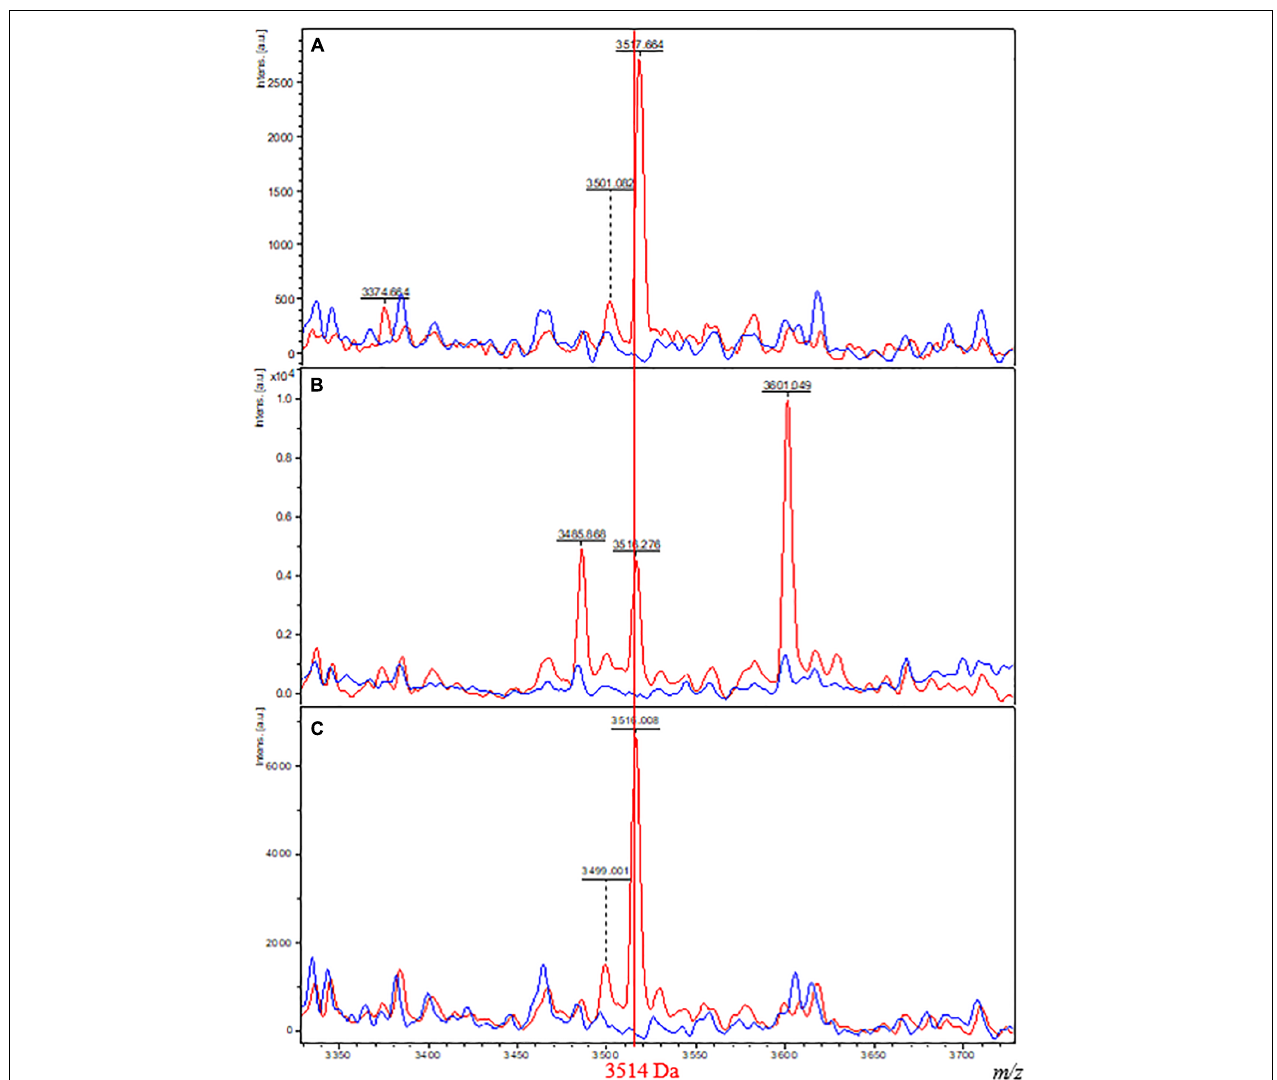
FIGURE 3 | Comparison of MALDI-TOF spectra plots from isolates of Class 1 and 2 grown on different culture media. Spectra of one isolate belonging to Class 1 ( M. tuberculosis Lineage 2, red) and one isolate belonging to Class 2 ( M. bovis BCG, blue) grown on M4 agar (A) , M7H10 (B) , and Coletsos (C) media. The x -axis shows the m/z values on a reduced window of 350 Da comprising the specific biomarker of interest at 3,514 Da. The y -axis indicates the intensity of peaks in arbitrary units.